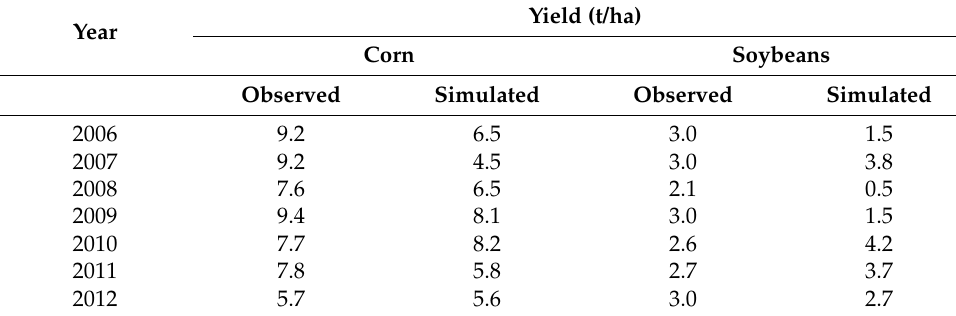
Table 1. USDA NASS DeKalb County crop yields for 2006–2012. Year